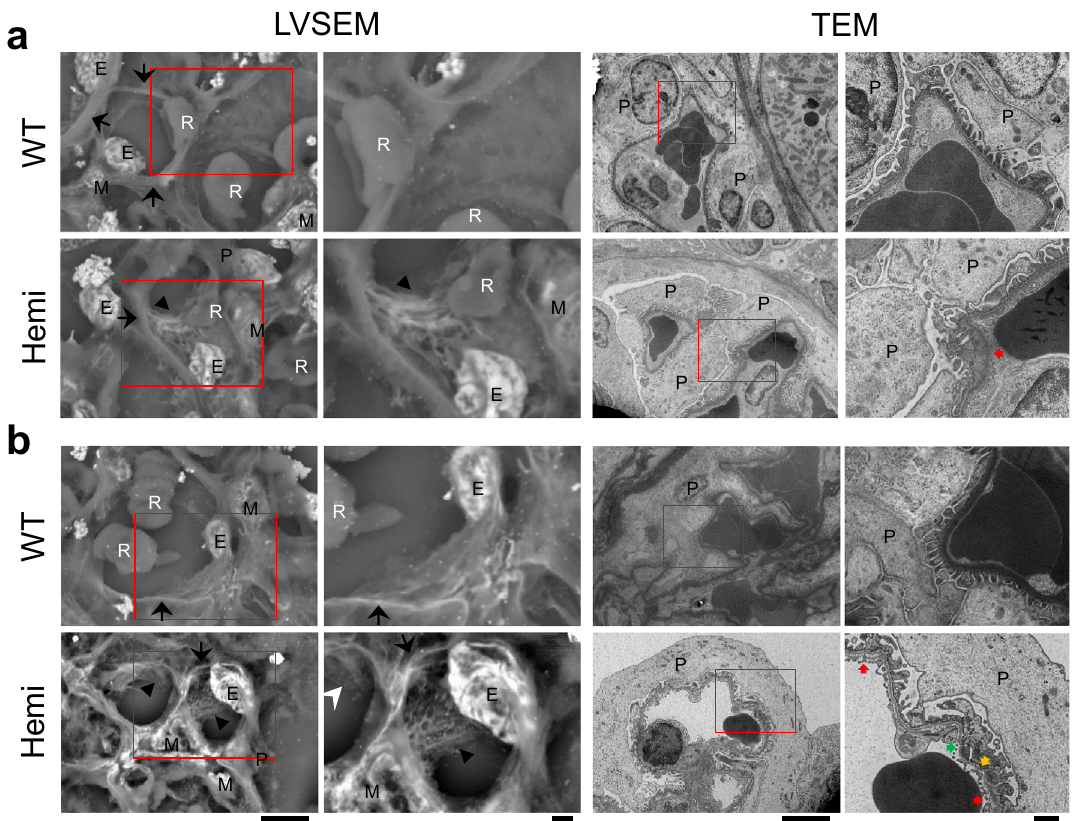
Figure 3. Electron photomicrographs of glomerular basement membranes in Col4 α 5 mutant rats. (a,b) Representative low-vacuum scanning electron microscopy (LVSEM, left) and transmission electron microscopy (TEM; right) images in wildtype (WT) and Col4 α 5 mutant (Hemi) males at 8 weeks (a) and 20 weeks (b) of age. Black and white arrowheads indicate the coarse meshwork structure of the GBM. Black arrows indicate cut side of the capillary walls. Red arrows indicate thickening of the GBM. Green arrows indicate thin patterns of the GBM. Yellow arrows indicate the splitting or fragmenting of the lamina densa. Red insets are revealed the higher magnification of left panels. E: Endothelial cells, M: Mesangial cells, P: Podocytes, R: Red blood cells. Scale bars , 5 µm (left), 1 µm